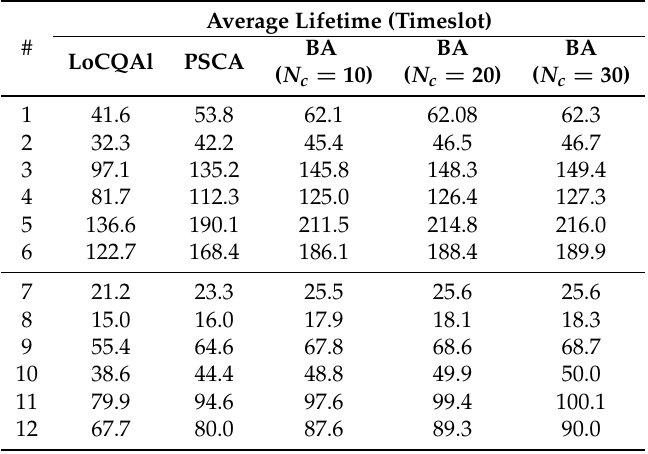
Table 6. Average lifetime in the second